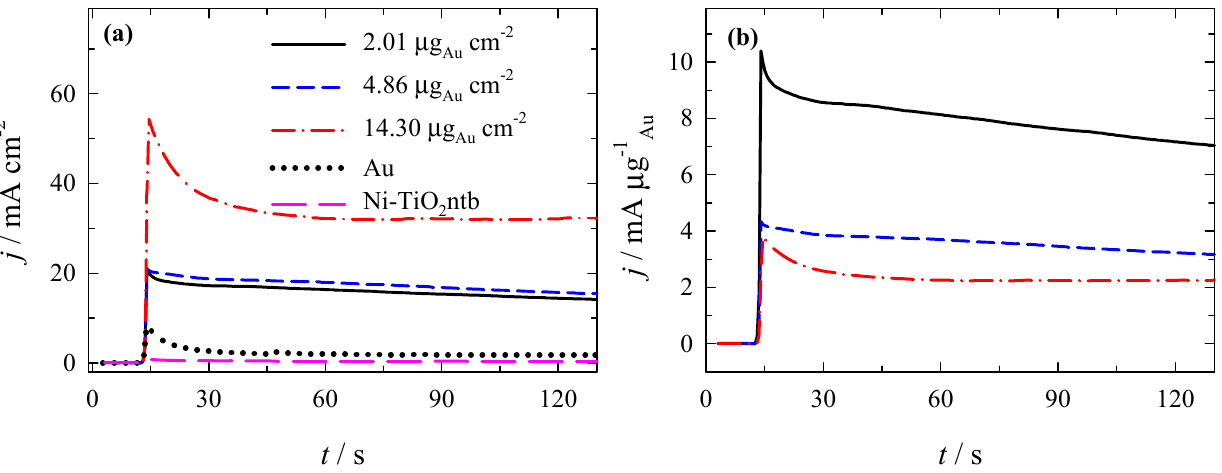
Figure 9. ( a ) Chronoamperometry curves for the Au (dotted line), Ni-TiO 2 ntb (long dash line), and AuNi-TiO 2 ntb catalysts were recorded in a 0.05 M NaBH 4 + 1 M NaOH solution at 25 °C. AuNi-TiO 2 ntbs were prepared by dipping TiO 2 ntb in the Ni plating solution operated at 85 °C for 5 s, followed by their dipping in the Au plating solution for time (s): 60 (solid line), 300 (dashed line), and 1800 (dash − dot-dashed line). The potential was held at E = 0 for 10 s, then set to − 0.3 V for 2 min. ( b ) Chronoamperometry curves were normalized by the Au loadings for each AuNi-TiO 2 ntb catalyst.